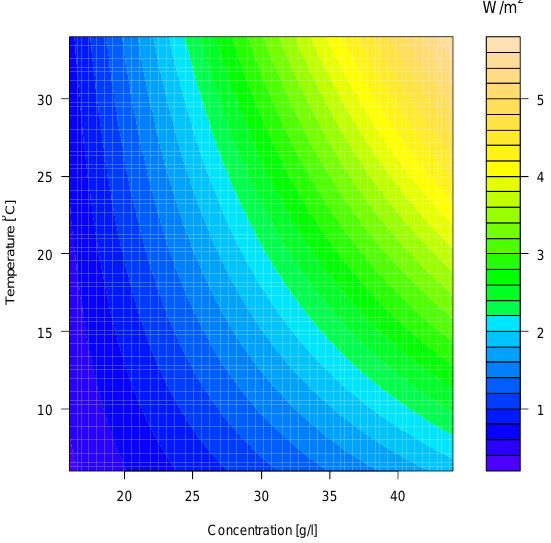
Figure 8. Contour plot of the specific power (W/m 2 ) as function of concentration and temperature for the CTA membrane. Note that the operating pressure has been optimized for each combination of concentration and temperature.